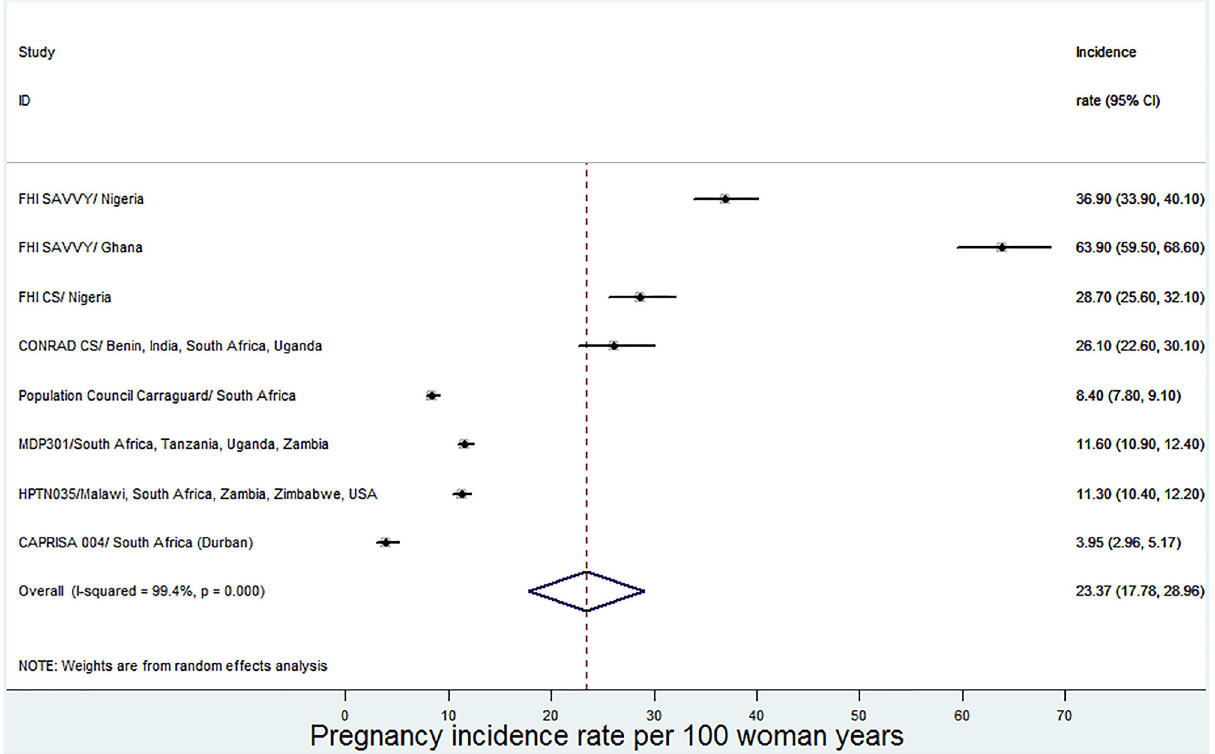
Figure 2. Forest plot for the meta-analysis of incidence rates of pregnancy (per 100 woman-years) in microbicide